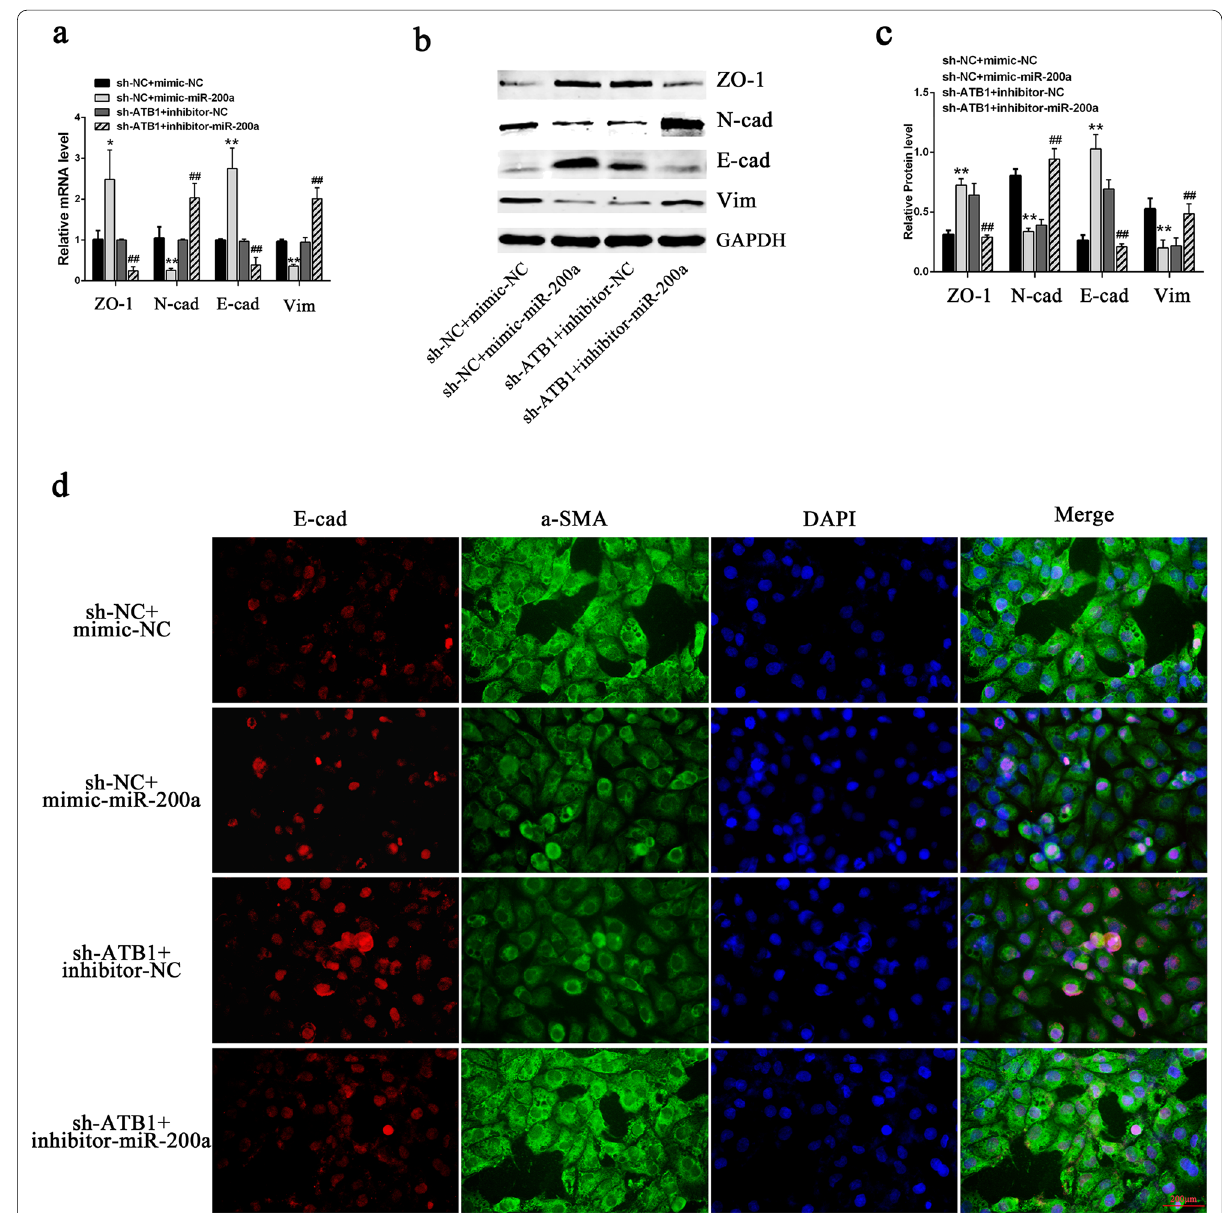
Fig. 7 LncRNA-ATB regulates the COM-induced EMT via miR-200a. a – c The mRNA a or protein b levels of EMT markers in respective HK-2 cell lines exposed to COM and cotransfected with miR-200a mimics or inhibitors. c Quantitative results of EMT marker-protein levels. d The expression levels of E-cadherin and α-SMA were detected by immunofluorescence. Scale bars 200 μm. All above the experiments were repeated 3 times, values are = mean SD; * P < 0.05, ** P < 0.01 VS. sh-NC mimic-NC group; ## P < 0.01 VS. sh-ATB1 inhibitor-NC ± + +